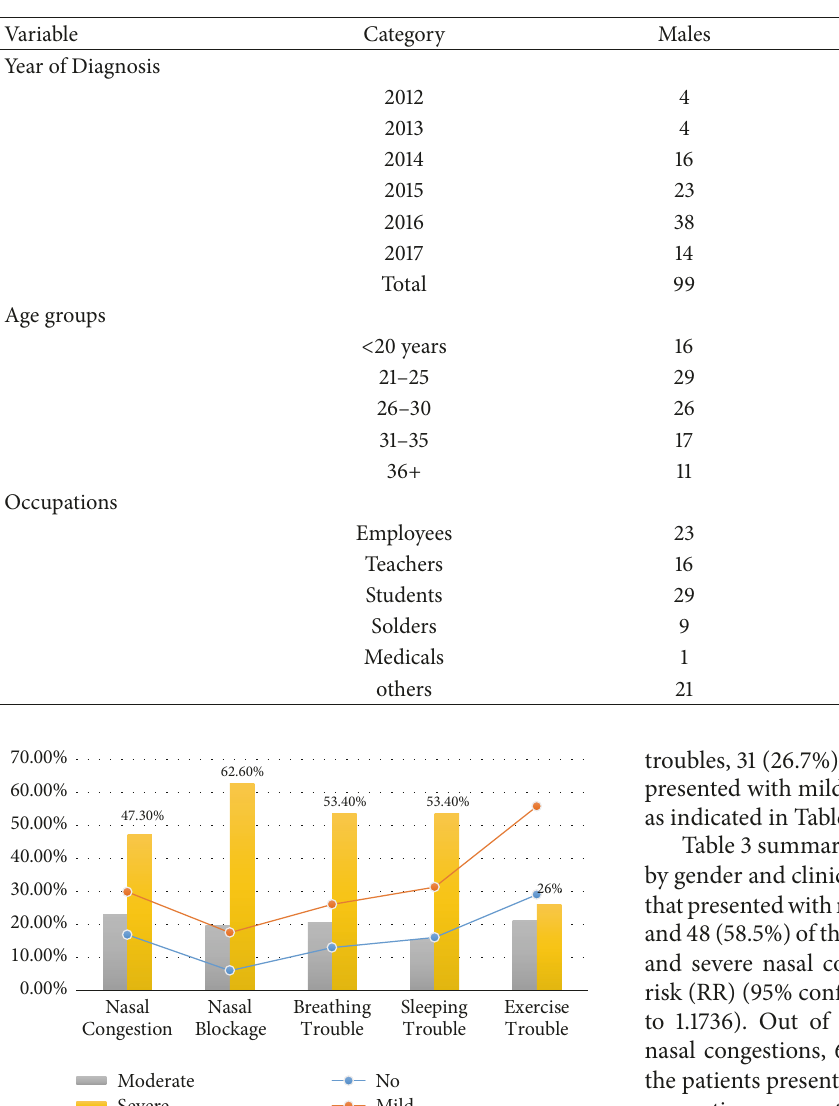
Table 1: Study subjects by demographical characteristics.